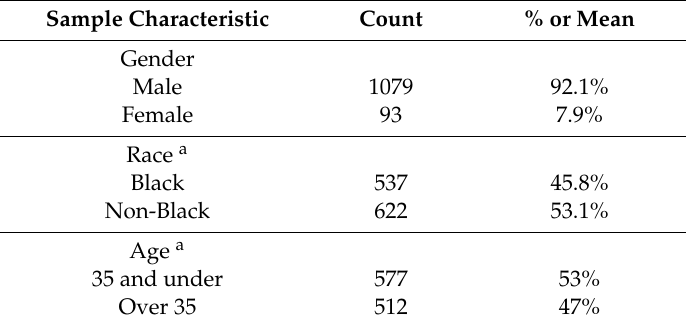
Table 1. Sample ( n =